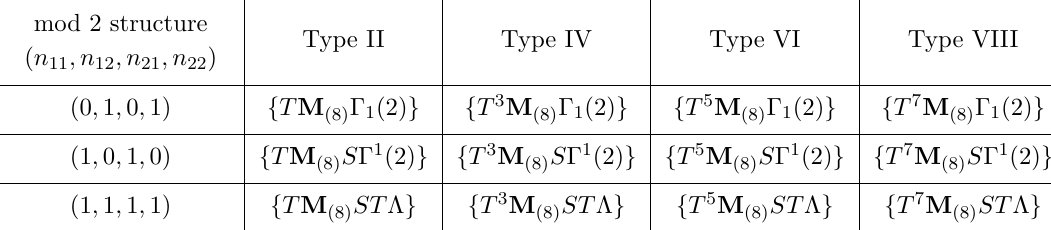
Table 21 . Classification of Types II, IV, VI, VIII for D = 8 .